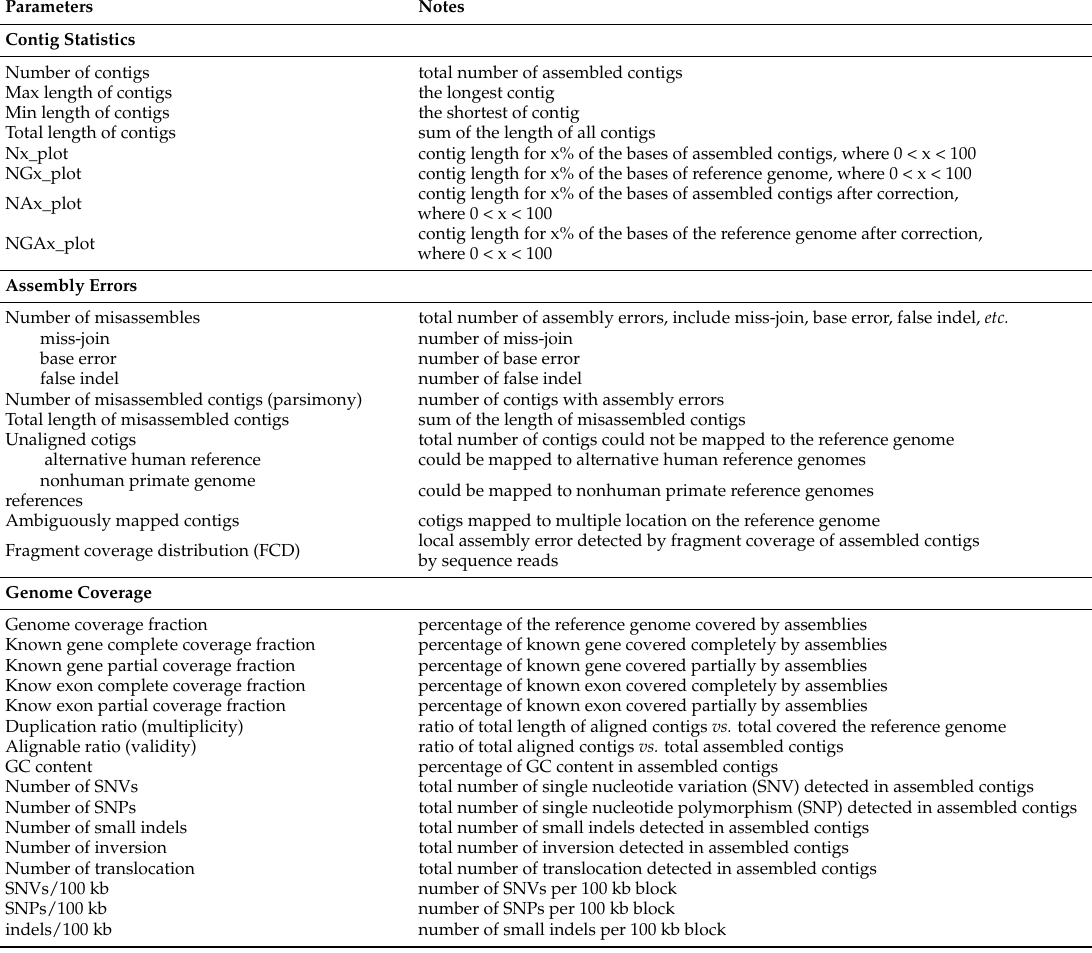
Table 4. Parameters for quality assessment of assembled